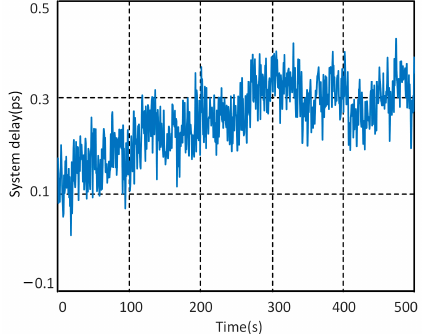
Figure 4. Measurement results when FTD is fixed. ( a ) measured peak frequencies (red) and peak phases (blue); ( b ) the number of periods (red) and normalized phases (blue). Figure 5. The system delay with a fi xed FTD.